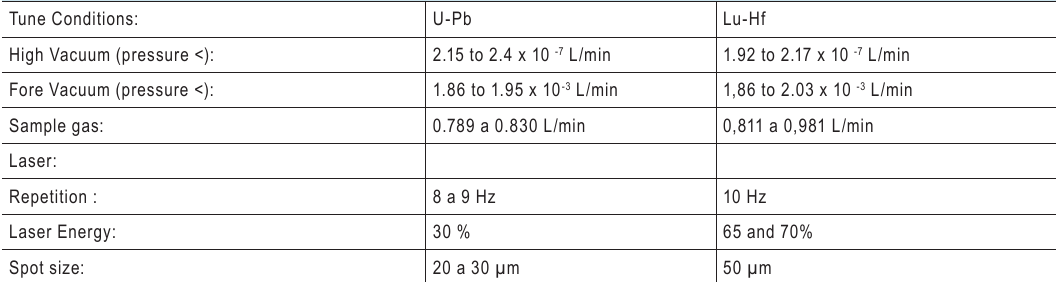
Table 3: LA-ICP-MS U-Pb and Lu-Hf analytic conditions during analysis performed for this study